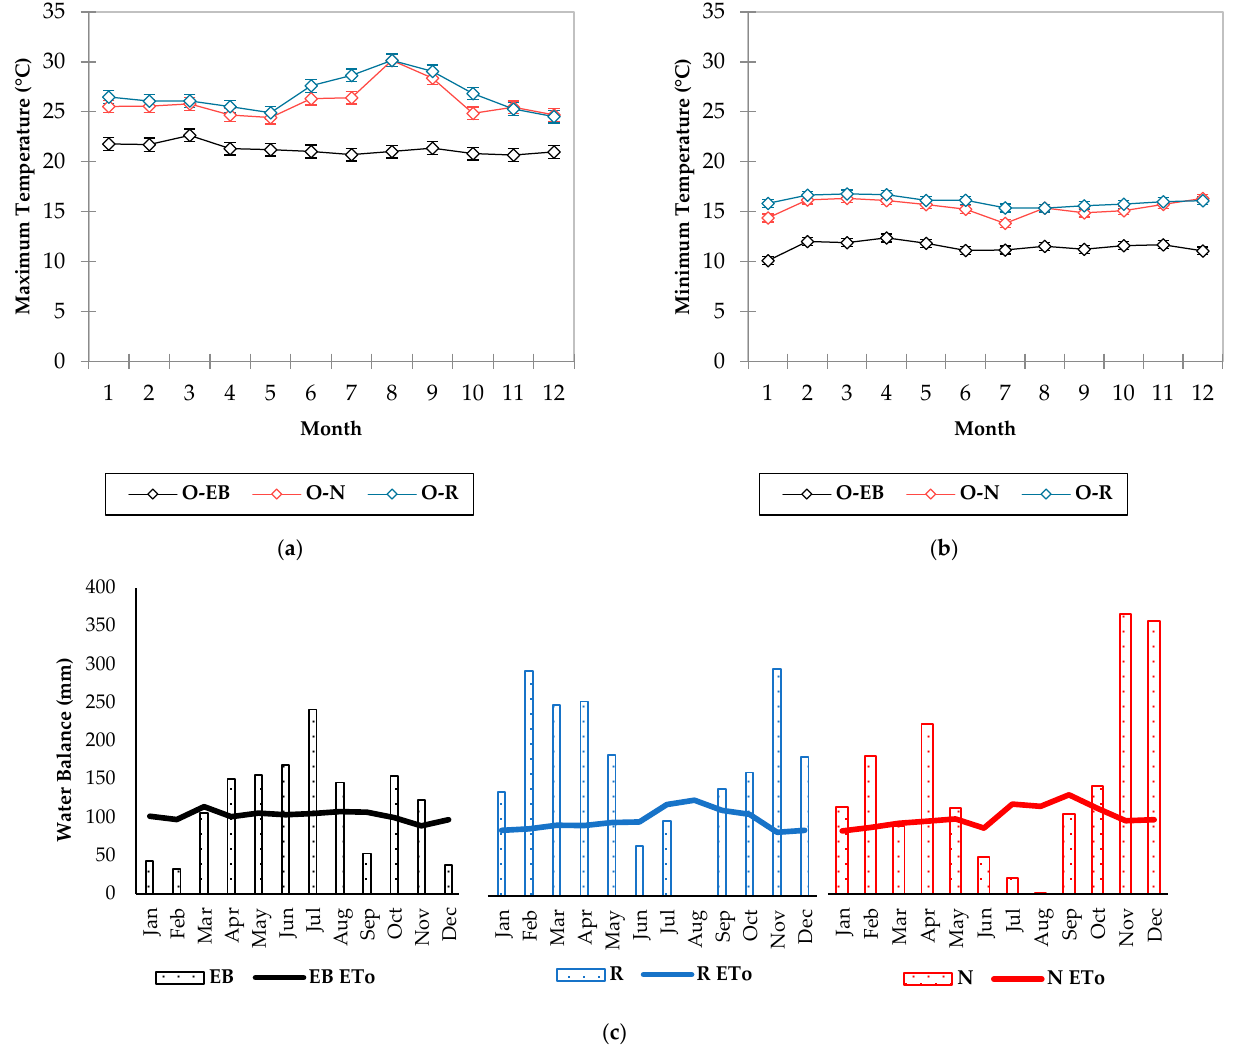
Figure 2. Climate conditions of the Hass avocado experimental zones corresponding to the following variables: ( a ) maximum temperature; ( b ) minimum temperature; and ( c ) evapotranspiration. O-EB: Orchard EB. O-N: Orchard N. O-R: Orchard R. ETo: evapotranspiration.